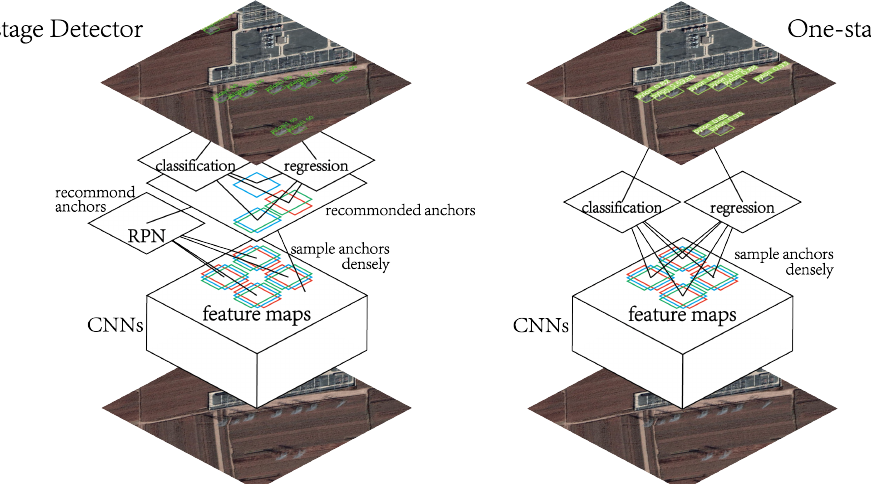
Figure 1. Basic structure of deep-learning-based detection networks from image input to result output: ( Left ) two-stage detectors; and ( Right ) one-stage detectors. These detectors firstly extract features using Convolutional Neural Network (CNN), and then densely sampled from different location to get anchors. Difference between two-stage and one-stage is mainly reflected on whether utilizes Region Proposal Network (RPN) [19]. Two-stage detectors classify the anchors recommended by RPN and regress the bounding-box to draw near the ground truth box, while one-stage detectors do classification and regression on all